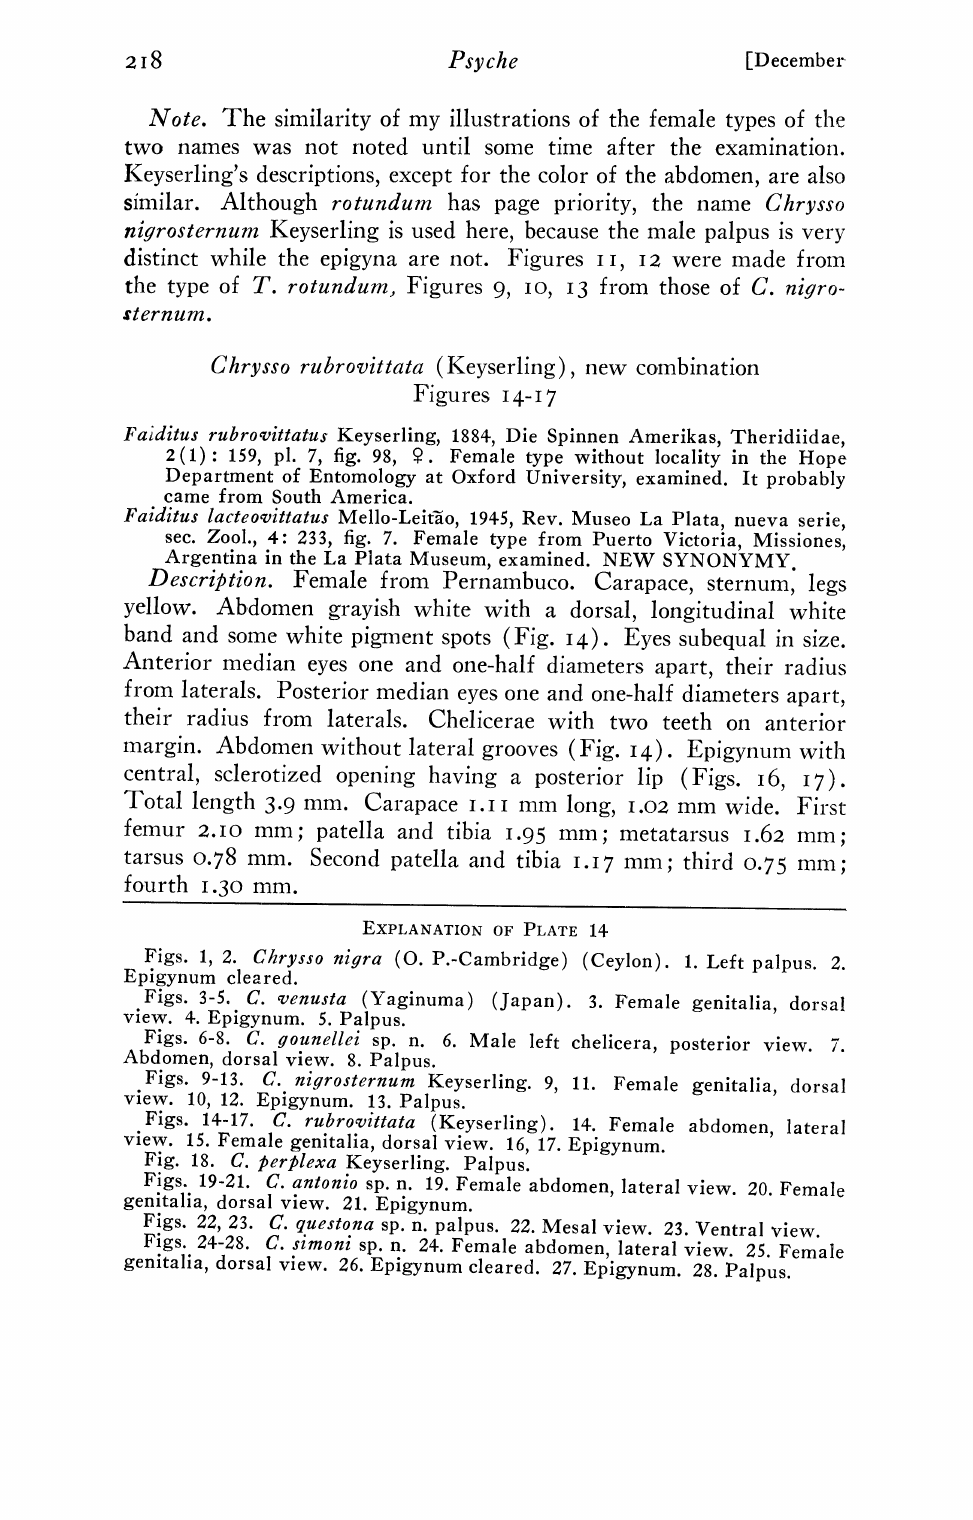
Figs. 1, 2. Chrysso nigra (0. P.-Cambridge) (Ceylon). 1. Left palpus. 2. Epigynum cleared. Figs. 3-5. C. enusta (Yaginuma) (Japan). 3. Female genitalia, dorsal view. 4. Epigynum. 5. Palpus. Figs. 6-8. C. gounellei sp. n. 6. Male left chelicera, posterior view. 7. Abdomen, dorsal view. 8. Palpus. Figs. 9-13. C. nigrosternum Keyserling. 9, 11. Female genitalia, dorsal view. 10, 12. Epigynum. 13. Palpus. Figs. 14-17. C. rulroittata (Keyserling). 14. Female abdomen, lateral view. 15. Female genitalia, dorsal view. 16, 17. Epigynum. Fig. 18. C. perplexa Keyserling. Palpus. Figs. 19-21. C. antonio sp. n. 19. Female abdomen, lateral view. 20. Female genitalia, dorsal view. 21. Epigynum. Figs. 22, 23. (7. questona sp. n. palpus. 22. Mesal view. 23. Ventral view. Figs. 24-28. C. simoni sp. n. 24. Female abdomen, lateral view. genitalia, dorsal view. 26. Epigynum cleared. 27. Epigynum. 28.